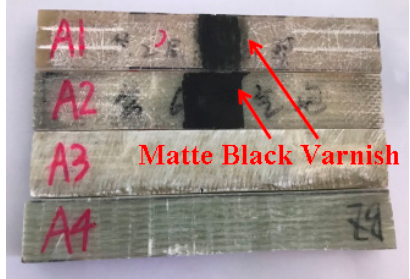
Figure 1. Tensile test specimen.